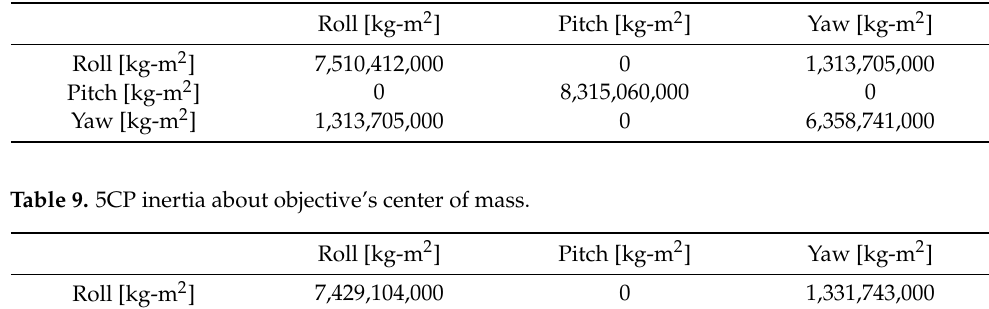
Table 8. 4CP inertia about objective’s center of mass.